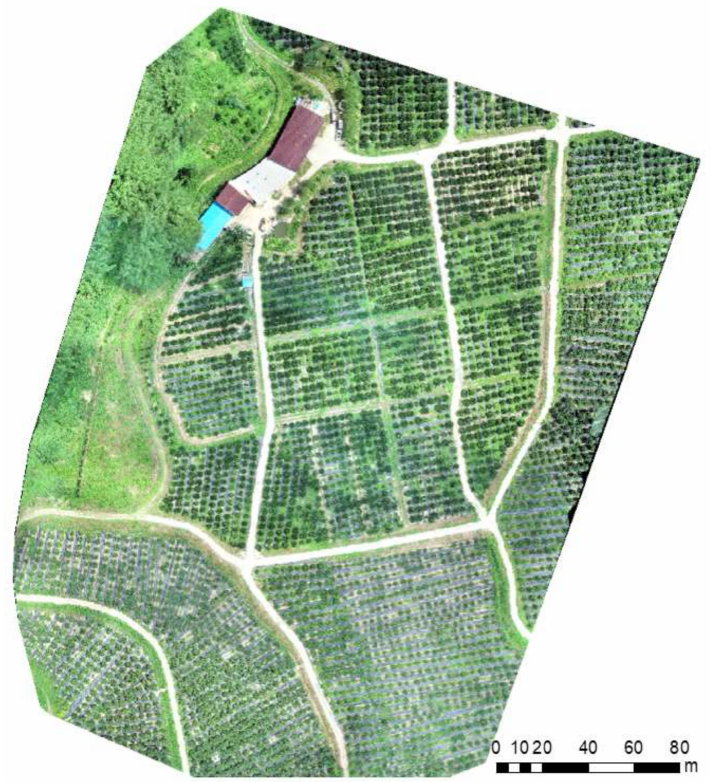
Figure 5. Orchard orthophoto map drawn based on UAV remote sensing